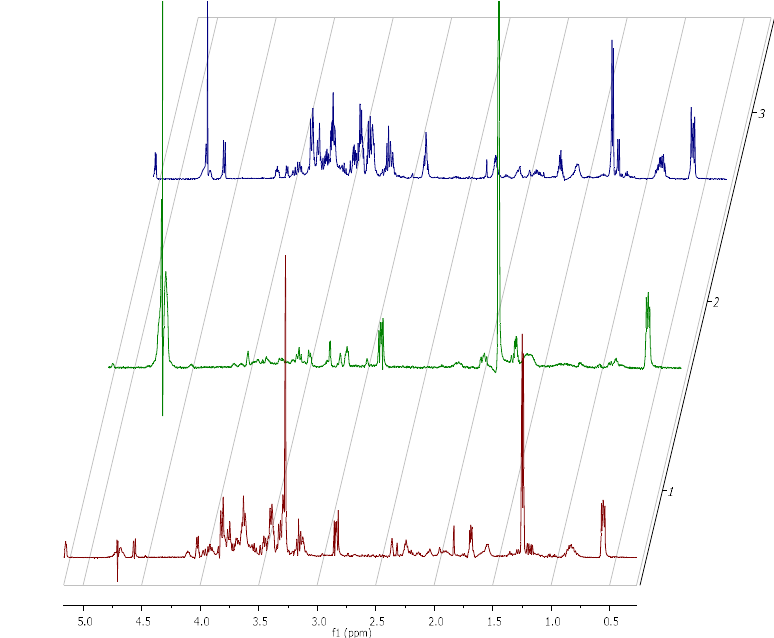
Figure 10. A part of the 1 H NMR spectrum presenting metabolites released from L929 fibroblasts sample ( A ) or L929 fibroblasts with S. aureus biofilm ( B ) or compounds recorded from pure medium sample ( C ) after 24 h of